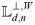
Cell infiltration in response to the chemoattractant.(A) Time evolution of profiles of a migratory glioma cell (blue circles) at t = 0, 80, 160, 320 min in response to the gradient of a chemoattractant on the top-right corner of the domain (red star). Black circle = the normal glial cells, blue outer circle = the membrane of a glioma cell, blue inner circle = nucleus of the glioma cell. (B) Time courses of the deformation of the nucleus to the left (Ld,n⊥,W) and to the right (Ld,n⊥,E(t)).